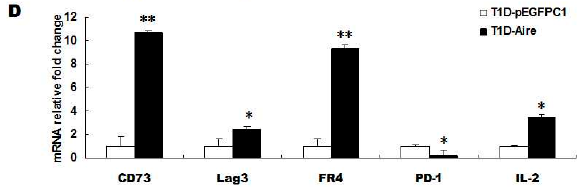
Figure 2. Aire cells altered the tolerance status of CD4 + T cells. ( A ) Splenocytes from STZ-induced T1D mice and WT mice co-cultured with Aire or control cells for 48 h. The apoptosis of CD4 + T cells was analyzed by FACS using the Annexin V-7AAD kit; ( B ) Splenocytes from STZ-induced T1D mice or WT mice co-cultured with Aire or control cells for 48 h in the presence of insulin. The IFN- γ expression levels in CD4 + T cells were examined by FACS; ( C , D ) Splenocytes from STZ-induced T1D mice and WT mice co-cultured with Aire or control cells for 48 h. The CD73, Lag3, FR4, PD-1 and IL-2 levels were detected by RT-qPCR in the splenocytes. The results are presented as the percentage of positive cells ± SD ( n = 5); each experiment was repeated at least three times. # p < 0.05, Insulin stimulation vs. control; * p < 0.05, ** p < 0.01, Aire vs. pEGFPC1.